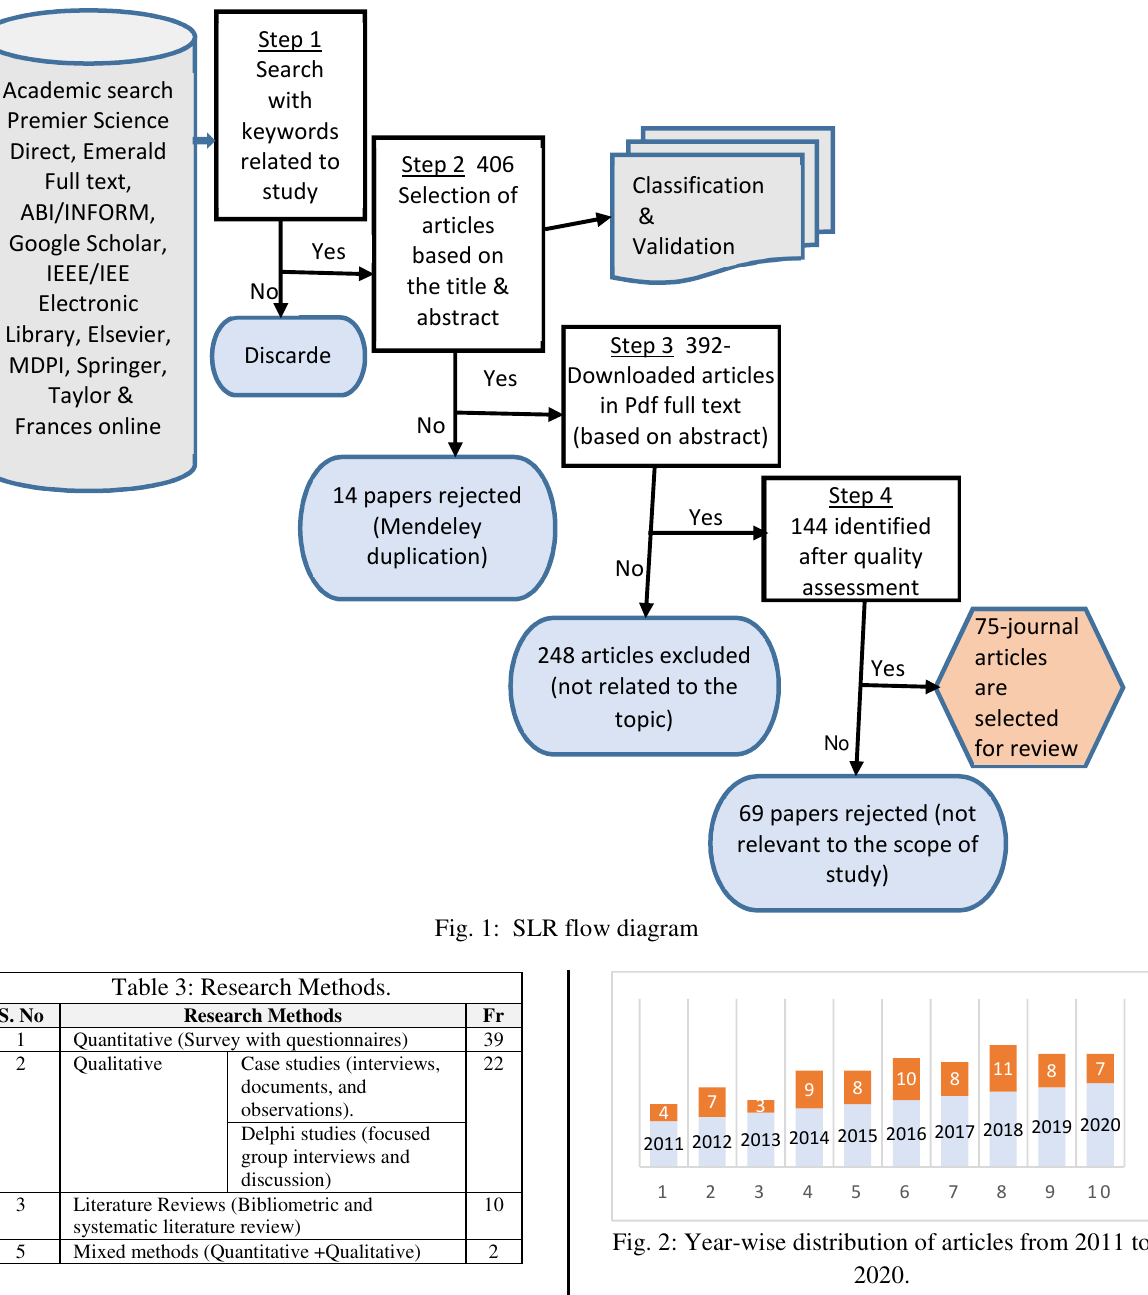
Fig. 2: Year-wise distribution of articles from 2011